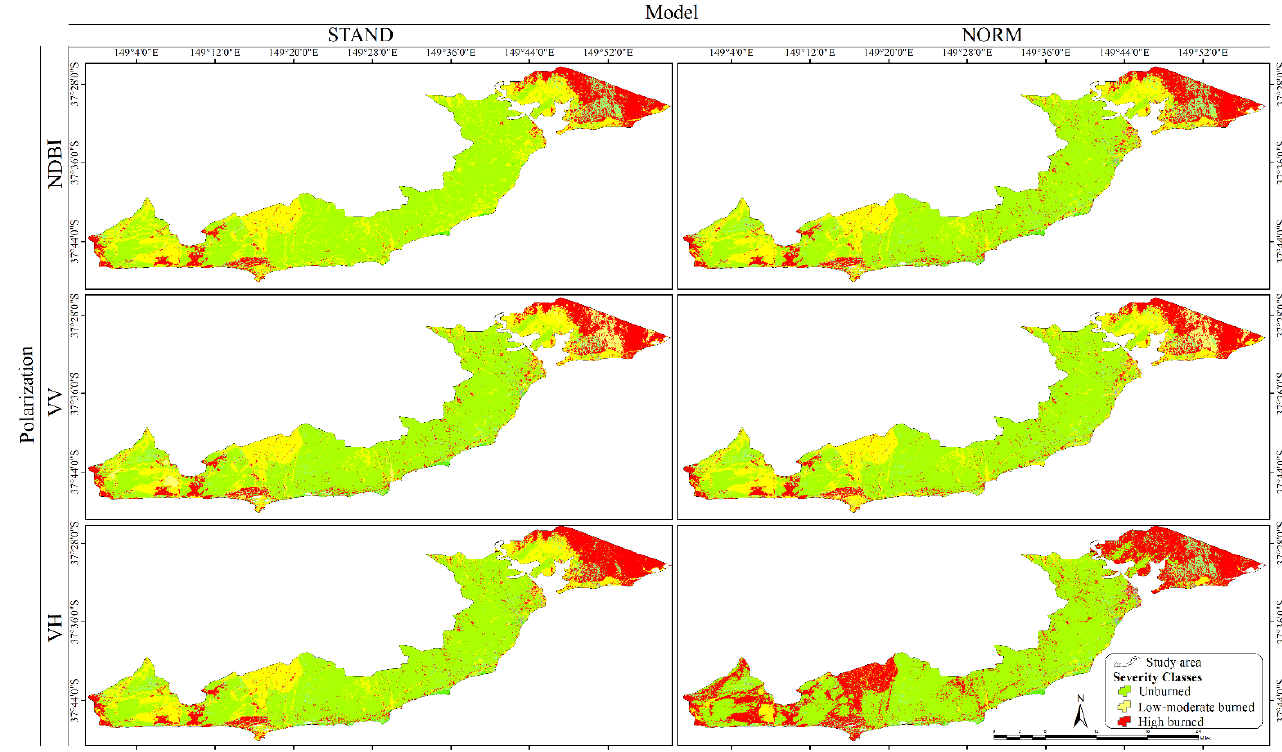
Figure A2. Mean of dry and wet condition.